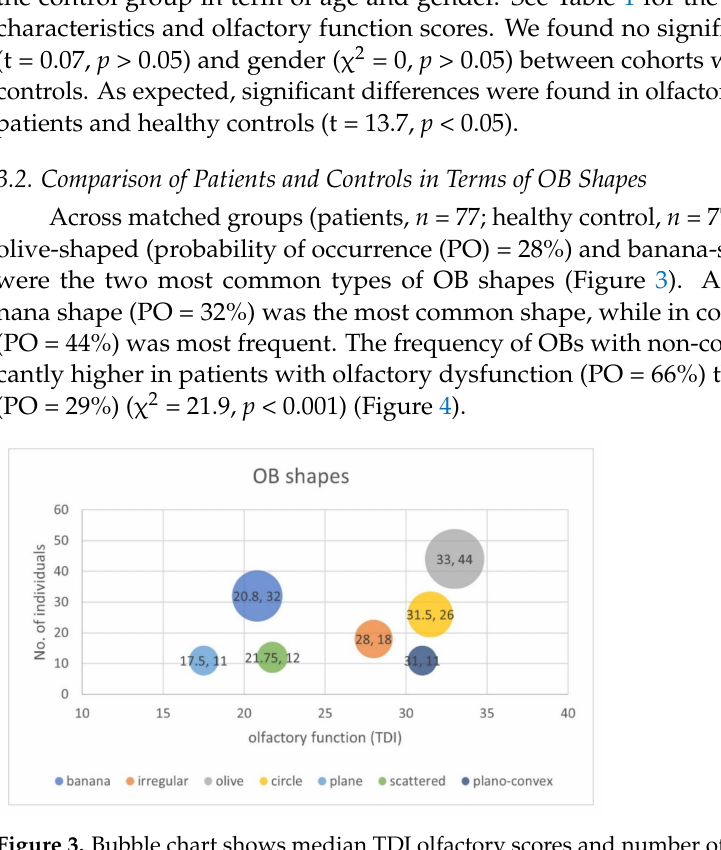
Figure 3. Bubble chart shows median TDI olfactory scores and number of investigated participants for OB shapes within each bubble (TDI scores; number). The size of the bubble indicates the number of individuals with the respective characteristic. Olive-shaped (28%, 44/154) and banana- shaped OBs (21%, 32/154) were the two most common types of OB shapes. Olive-shaped, circle, and plano-convex OB shapes had relatively higher median TDI total scores than other OB shapes. TDI =